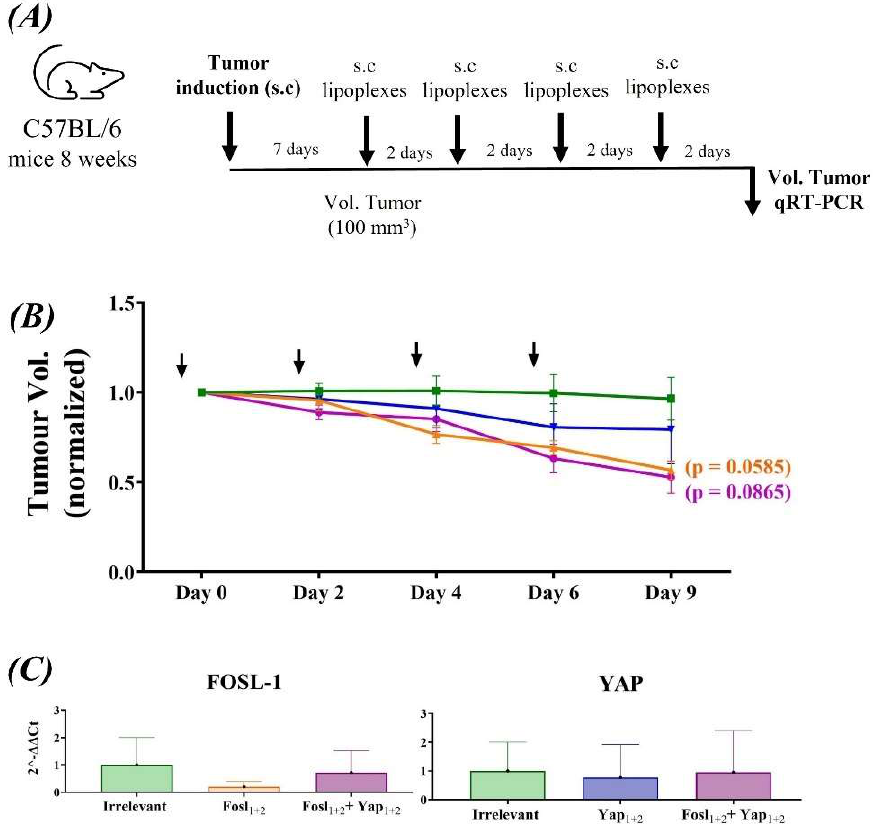
Figure 8. Anti-tumoral efficacy of lipoplexes in ATQ303G cell−allografted C57BL/6 mice ( n = 8). ( A ) Schedule of tumor cells inoculation and subsequent injection of the lipoplexes subcutaneously around the tumor. ( B ) Tumor volume was normalized at the first day of drug administration (7 days after tumor induction). ( C ) mRNA expression of FOSL-1 and YAP after 48 h of the last lipoplexes administration. Irrelevant (green), Fosl 1+2 (brown), Yap 1+2 (blue) and combination of Fosl 1+2 + Yap 1+2 (purple). For the statistical analysis, animals treated with Yap 1+2 , Fosl 1+2 and Fosl 1+2 + Yap 1+2 were compared to those treated with the irrelevant siRNA lipoplexes.